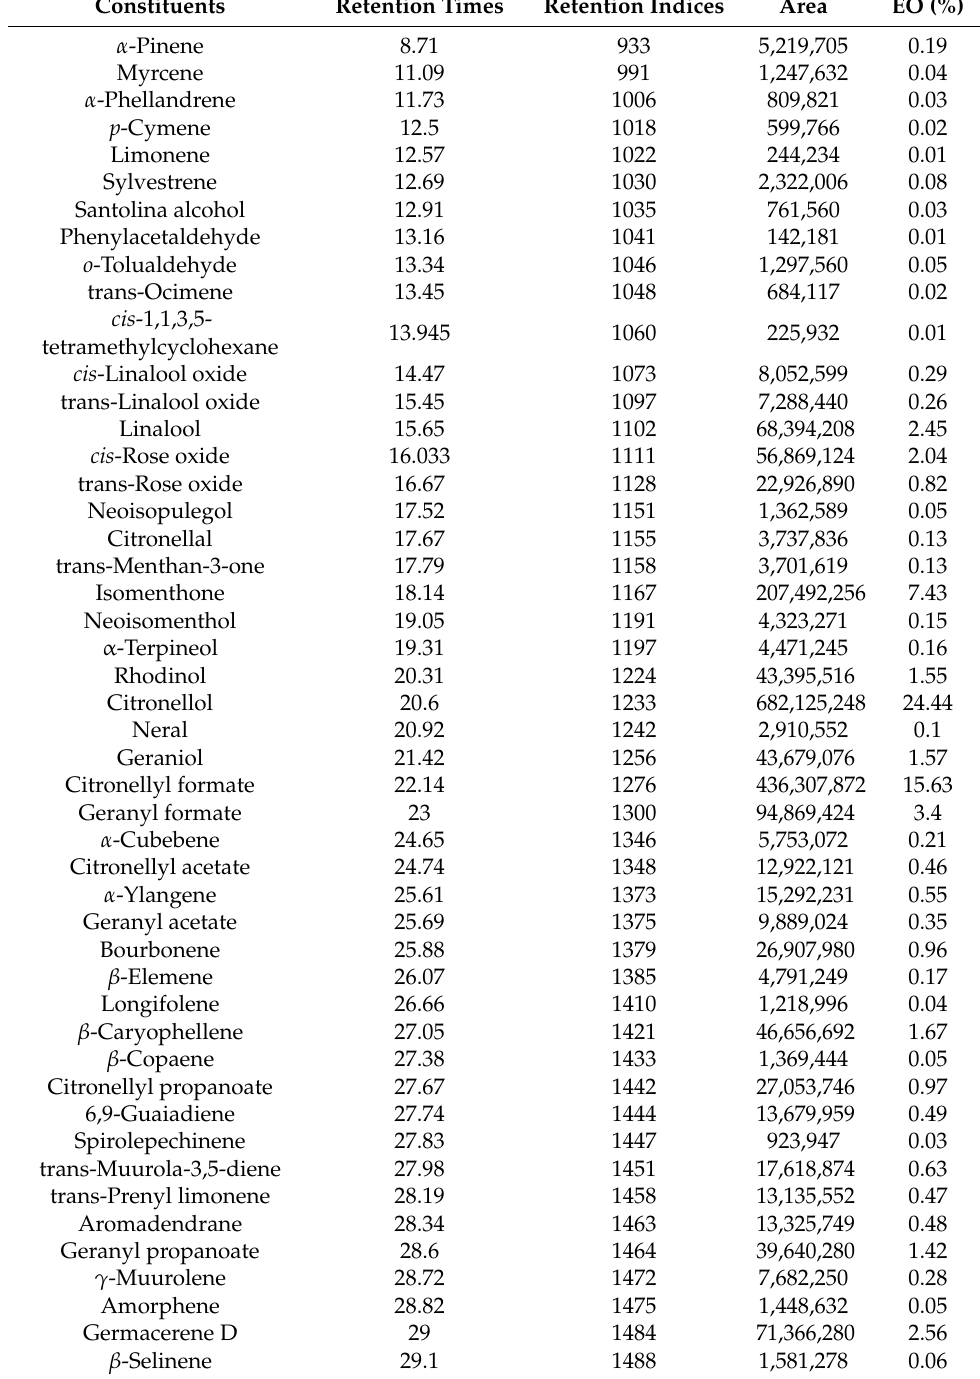
Table 1. The chemical components of